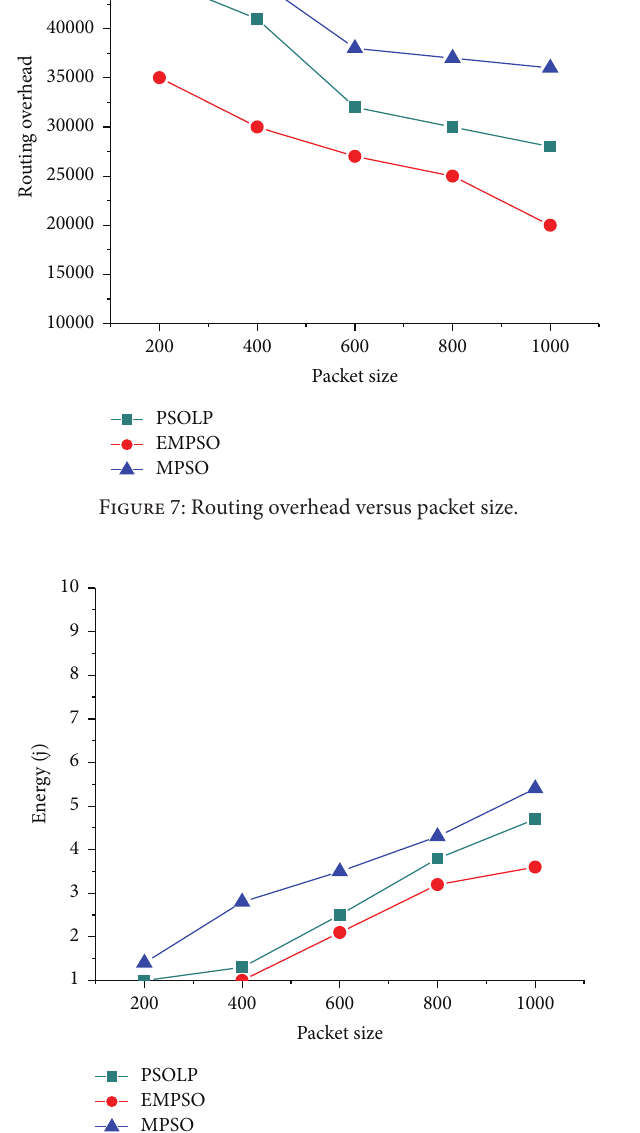
Figure 8: Energy consumption versus packet size.